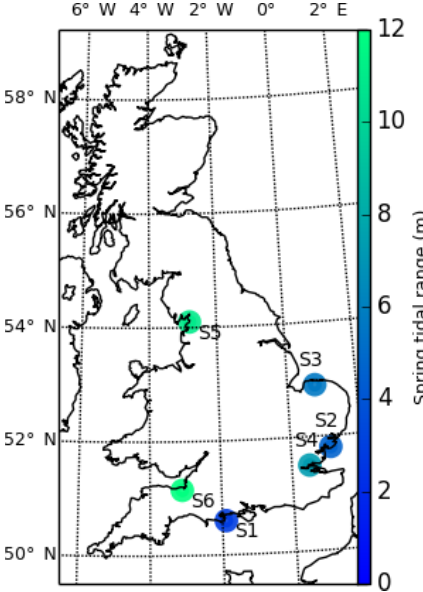
Figure 2. This map shows the six sites selected from the lidar col- lection of the UK environment agency, coloured by spring tidal range. The sites are numbered as follows: S1: Shell Bay, Dorset; S2: Stour Estuary, Suffolk; S3: Stiffkey, Norfolk; S4: Medway Estu- ary, Kent; S5: Jenny Brown’s Point, Lancashire; S6: Parrett Estuary,